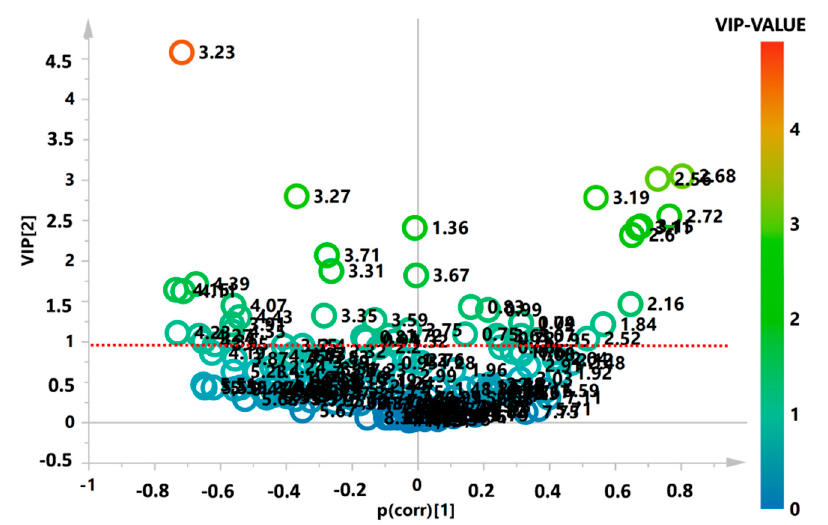
Figure 3. V-plot of the supervised OPLS-DA model, indicating the importance of the variables based on their position in the plot and their VIP-value. Variables with a value of > 1 were considered the most